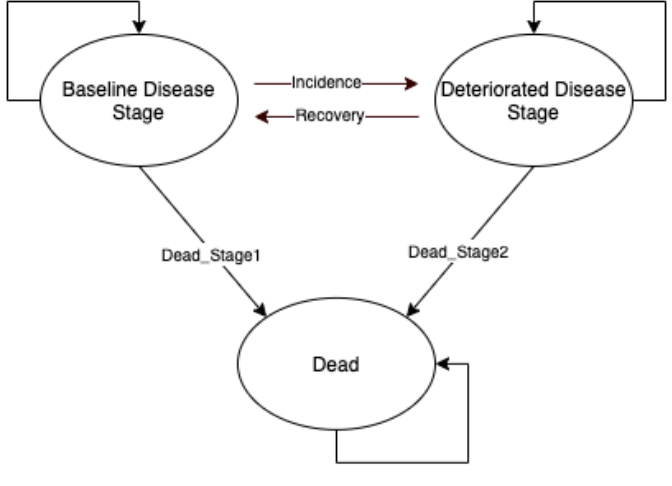
Figure 1. 3-state Markov model applied for the BeyondSilos cost-effectiveness